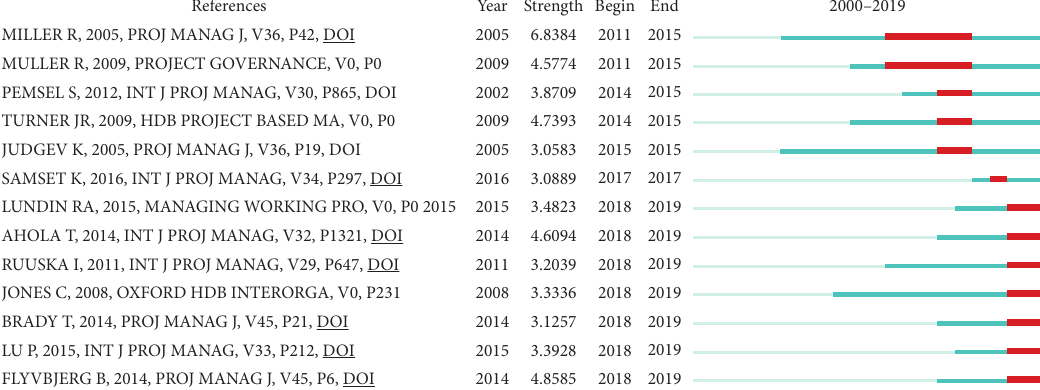
Figure 11: Top references with strong citation